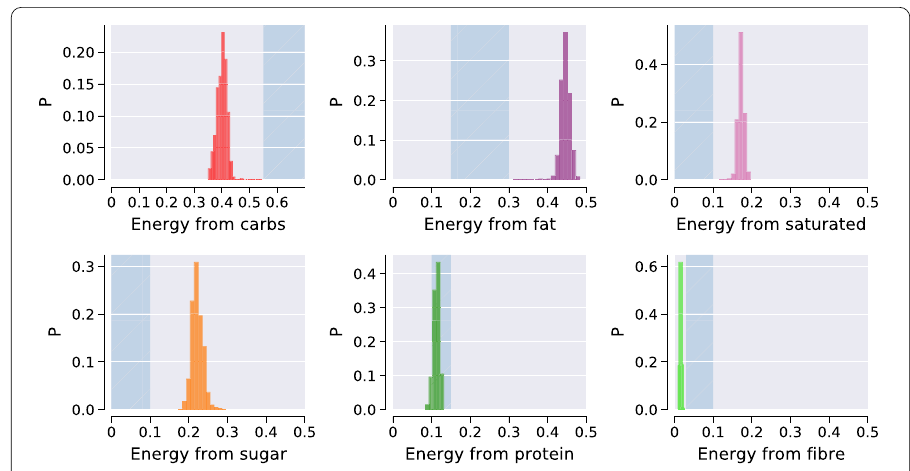
Figure 1 Frequency distributions of the fraction of an area’s total calories coming from each nutrient (computed with Formula (6)). The intervals recommended by the World Health Organization are shown as dark bands